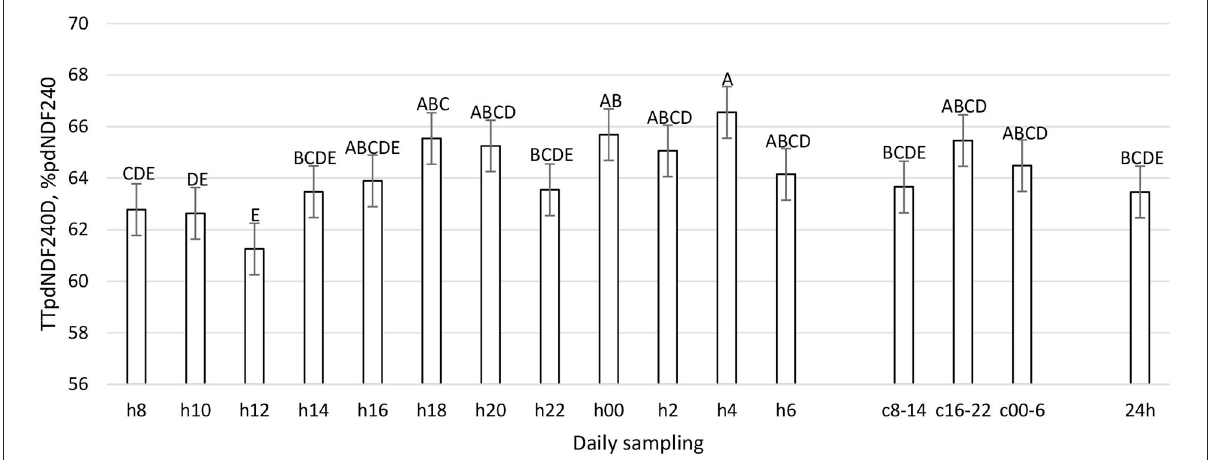
FIGURE12 Total Tract pdNDF 240h Digestibility (%pdNDF 240h ) (LSM ± SE) in sampled time points (daily samplings: h8, h10, h12, h14, h16, h18, h20, h22, h00, h2, h4, h6; composites: c8-14, c16-22, c00-6, 24h). Letters for differences ≤ 0.05. P-value = 0.04; SEM =